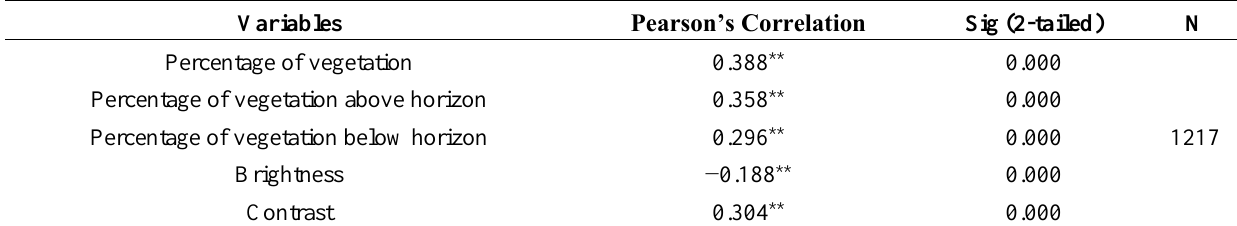
Table 2. Pearson’s correlation coefficients ( r ) between perceived safety and independent variables. Variables Pearson’s Correlation Sig